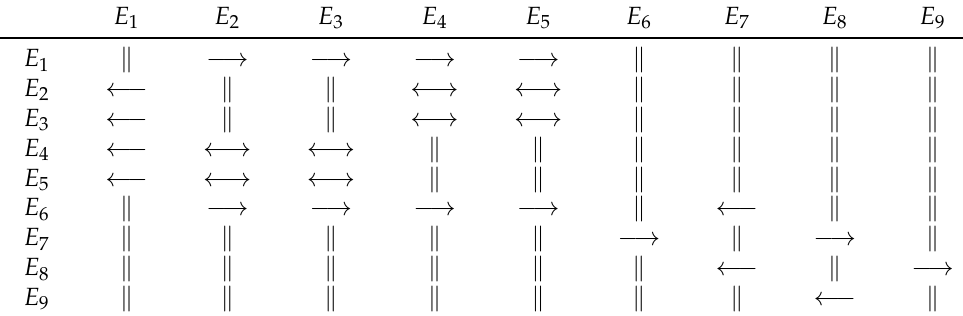
Table 3. EST for the courier company example.